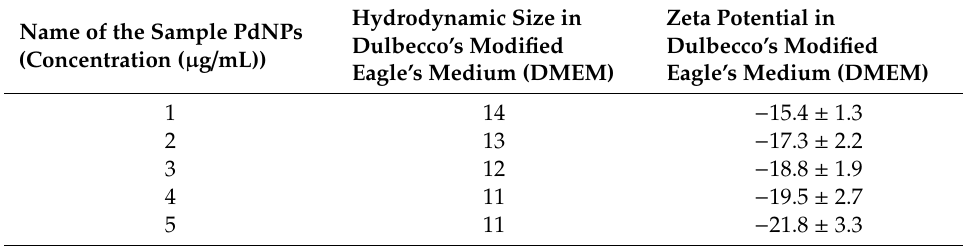
Table 1. Physicochemical characterization of PdNPs (mean ± SD, n = 3). Particle size and zeta